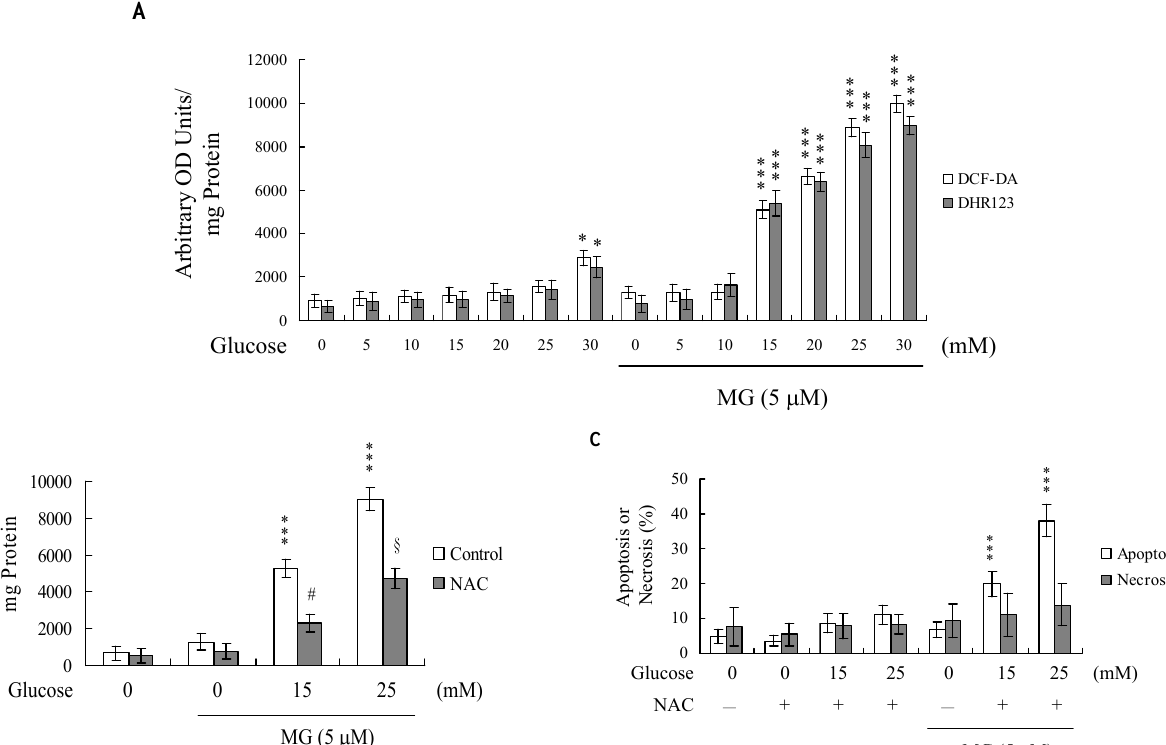
Figure 2. MG/HG co-treatment promotes oxidative stress in HMNCs.